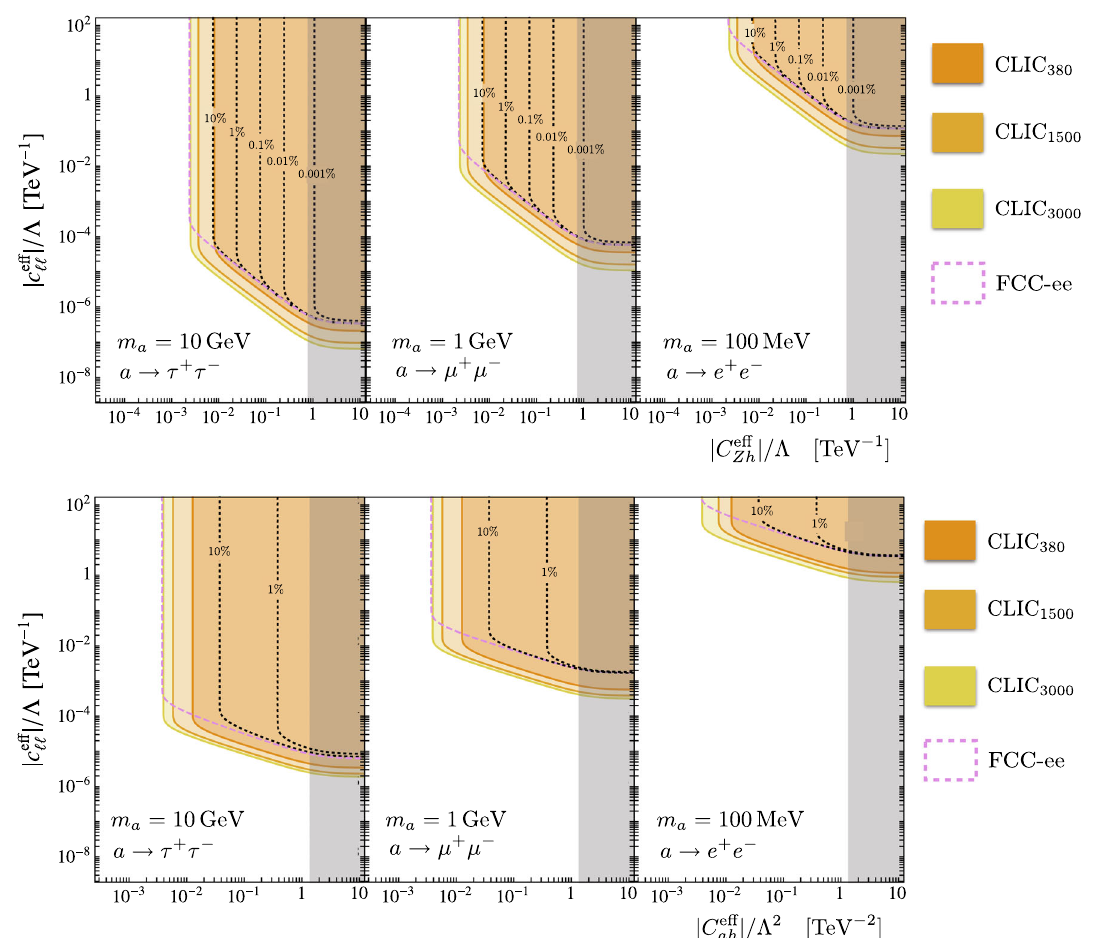
Fig. 11 Parameter regions which can be probed in the decay h → Za with a → (cid:10) − (cid:10) + (upper row) and h → aa with a → (cid:10) + (cid:10) − (lower row) at future e + e − colliders. The grey shaded area is excluded by LHC